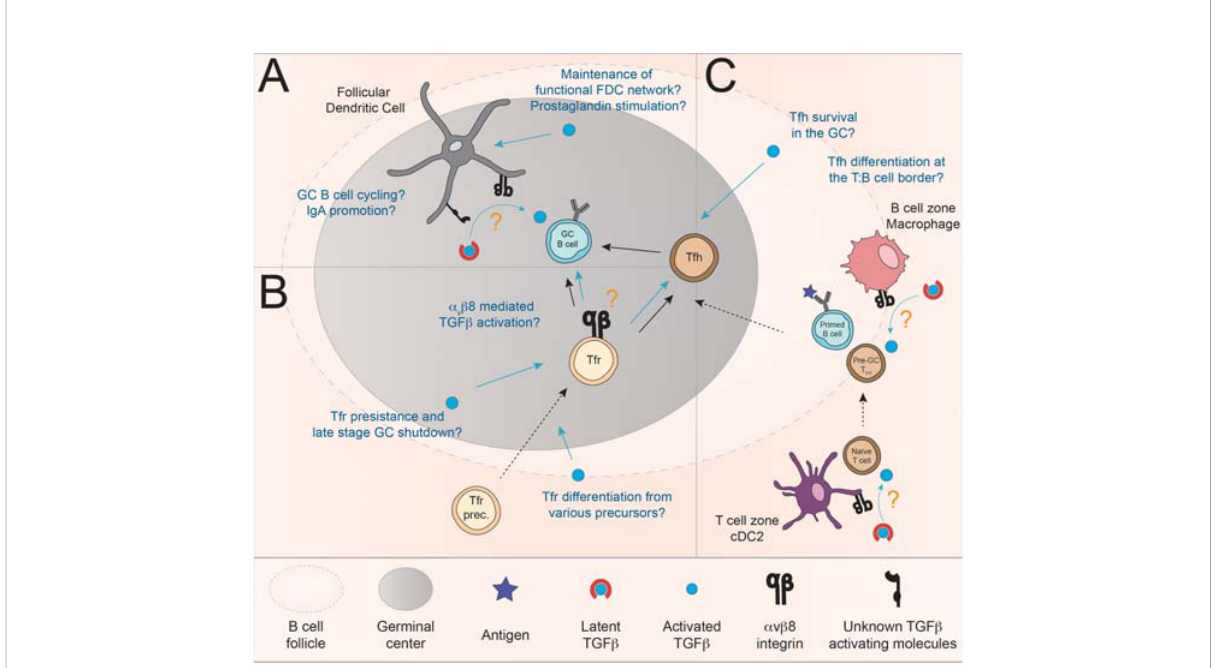
FIGURE 3 Model for the regulation of the GC reaction via the controlled delivery of active TGF b by a v b 8 integrin. (A) TGF b signaling in FDC may promote their survival and cytokine production and as such indirectly supports the GC reaction. In addition, given their expression of TGF b activating molecule, mucosal FDC themselves are a likely source of active TGF b (123). Furthermore, Albright and colleagues provided evidence that TGF b produced by FDC may be important for LZ to DZ traf fi cking of GC B cells. The mechanisms involved may include a v b 8 although formal demonstration is lacking (31). (B) Evidence suggests that TGF b is required, at least in certain situations, for the induction of Foxp3 + follicular T cells (Tfr) (36, 44, 67). In addition, Tfr may be able to regulate GC B cell responses via a v b 8-mediated activation of TGF b (61, 64, 142). (C) a v b 8- mediated activation of TGF b by follicular myeloid populations has been involved in the induction of Tfh (143). Additionally, a model in which TGF b promotes the survival of Tfh in the context of immunization have been proposed (35). In these contexts, the source of active TGF b is still currently